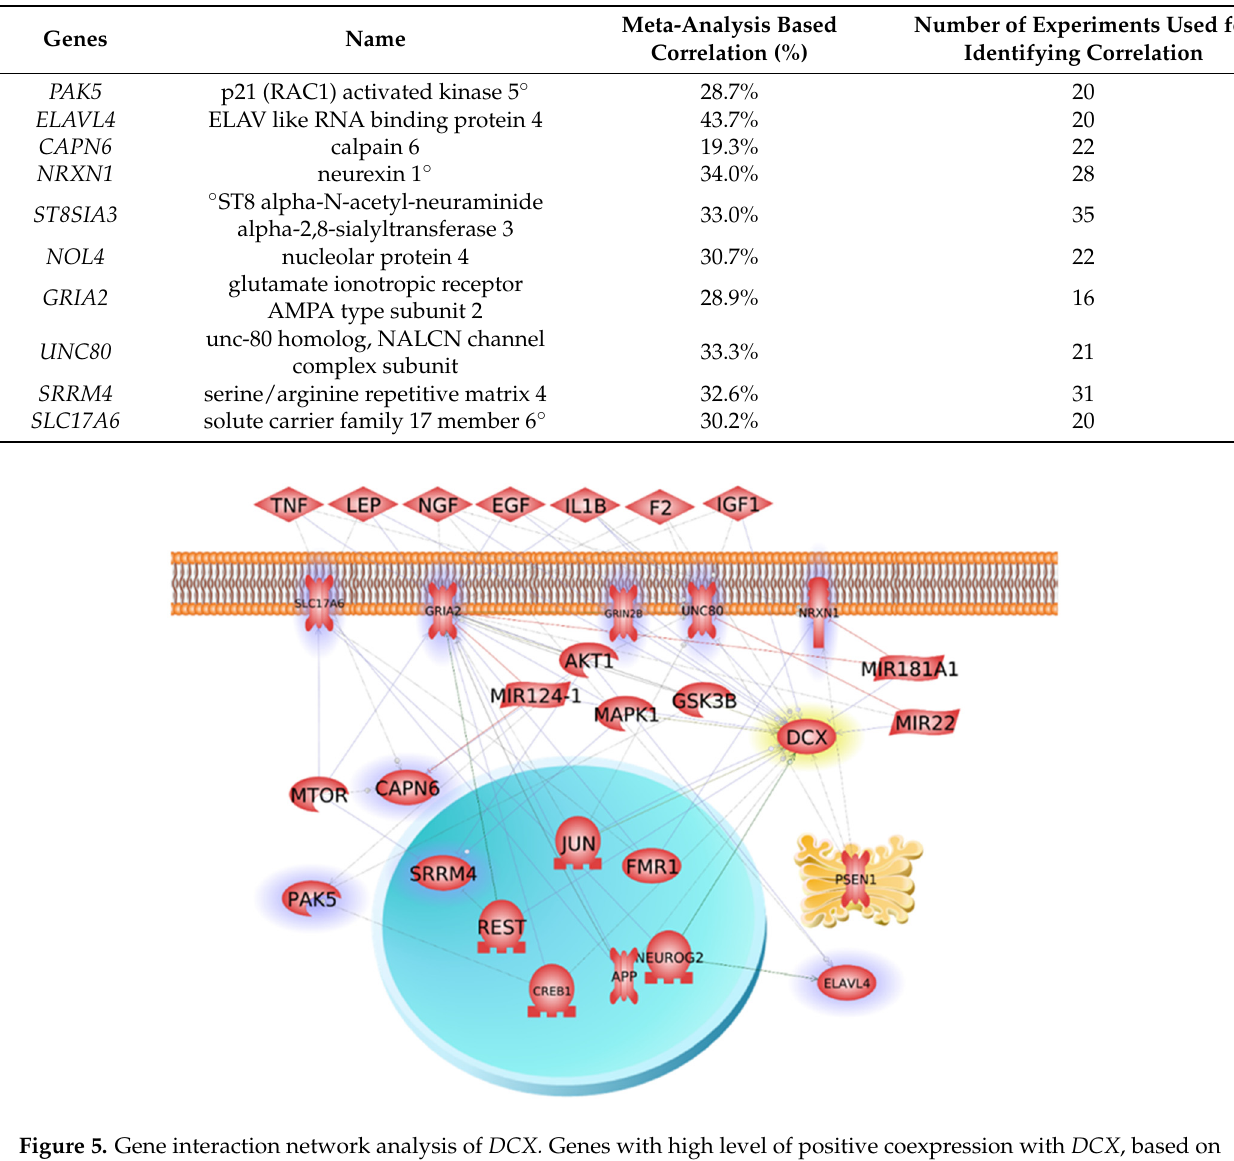
Figure 5. Gene interaction network analysis of DCX. Genes with high level of positive coexpression with DCX , based on meta-analysis, are highlighted.